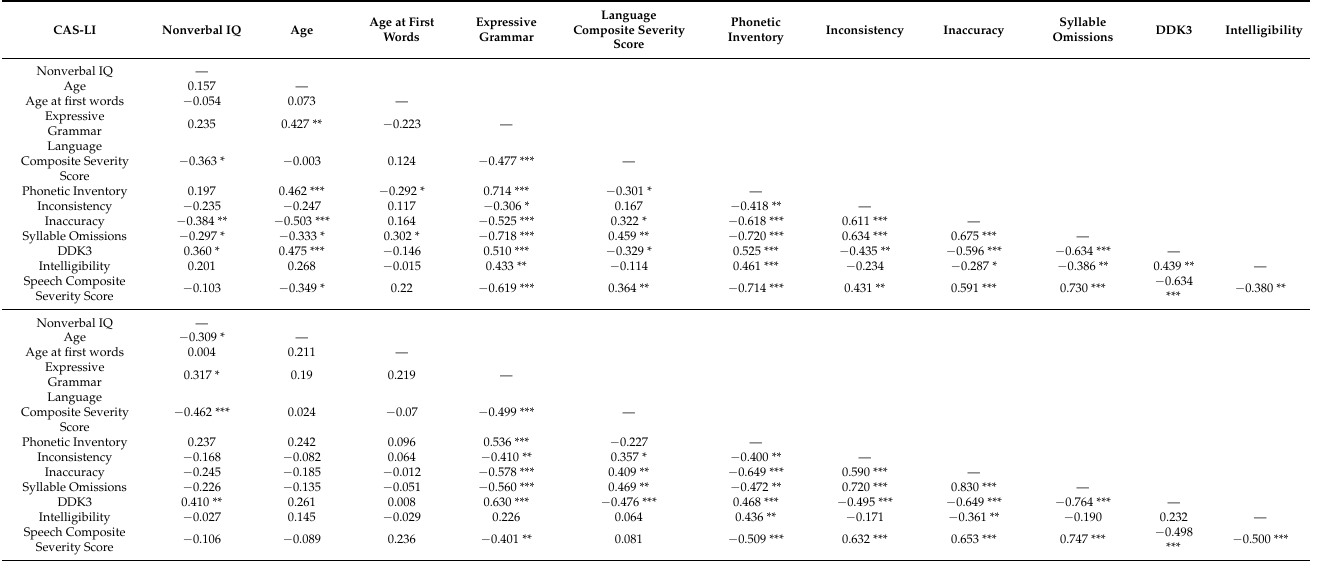
Table 3. Pairwise Spearman rho correlations in CAS-LI and CAS-LI +